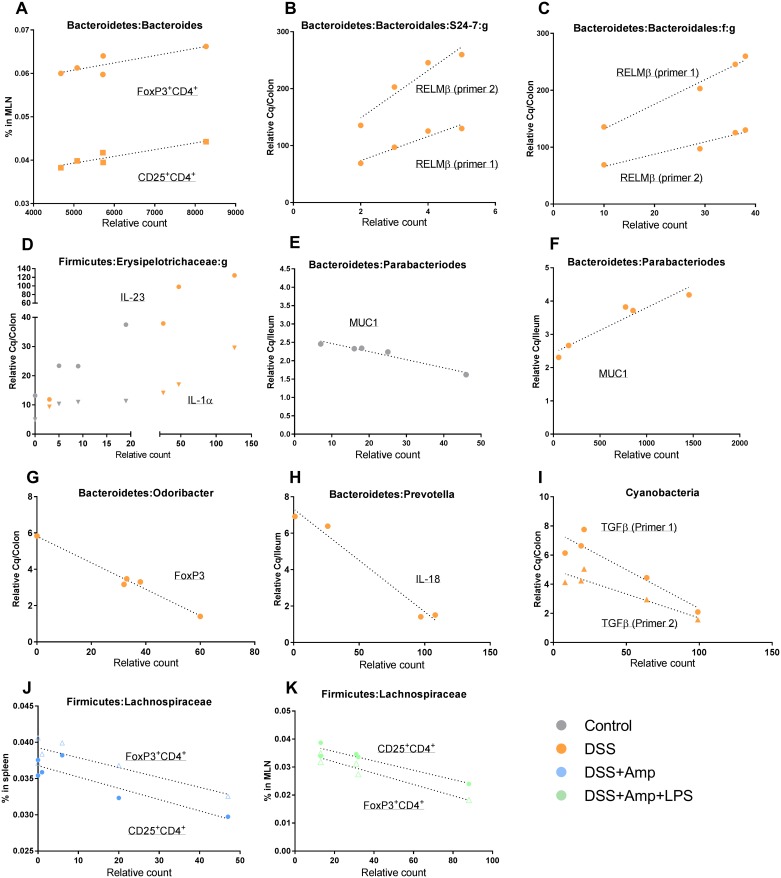
Correlations of relative counts of some operational taxonomic units and parameters.OTUs from gut microbiota and immunological parameters of untreated control mice and mice treated with 1.5% dextran sulfate sodium (DSS) alone or in combination with ampicillin (Amp) and lipopolysaccharides (LPS). The permutation based method was used to calculate r and p. Depicted p-values are FDR corrected. A-D: Day 3 of treatment. A. FoxP3+CD4+; p = 0.0485, r = 0.88, CD25+CD4+; p = 0.0087, r = 0.93. B. RELMβ (primer 1); p = 0.0022, r = 0.97, RELMβ (primer 2); p = 0.00009, r = 0.97. C. RELMβ (primer 1); p = 0.0131, r = 0.91, RELMβ (primer 2); p = 0.0100, r = 0.92. D. IL-23; p = 0.0391, r = 0.92, IL1α; p = 0.0012, r = 0.97. E+F: Day 1 post-treatment. E: p = 0.0046, r = 0.97. F: p = 0.0105, r = 0.96. G-K: Day 25 post-treatment. G. p = 0.0010, r = -0.9914. H. p = 0.0124, r = -0.9876. I. TGFβ (primer 1); p = 0.0244, r = -0.9251, TGFβ (primer 1); p = 0.0209, r = -0.9325. J. FoxP3+CD4+; p = 0.0208, r = -0.8799, CD25+CD4+; p = 0.0162, r = -0.8942. K. FoxP3+CD4+; p = 0.0154, r = -0.9449, CD25+CD4+; p = 0.0079, r = -0.9648.